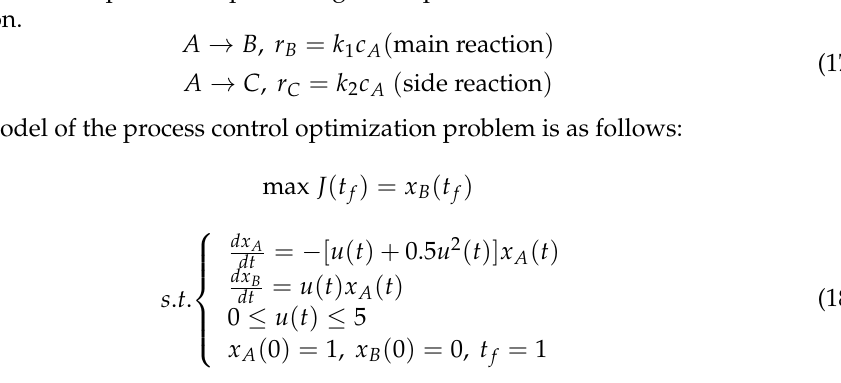
Figure 35. Optimal control trajectory and iteration curve ( 20 N = ). The optimal temperature control sequence, iterative convergence diagram, and optimal trajectory of state variables in the process of EBSO reaching the optimal concentration are shown in Figures 36 and 37 for when the number of segment points was 40 N = . Figure 36. Optimal control trajectory and iteration curve ( 40 N = ).